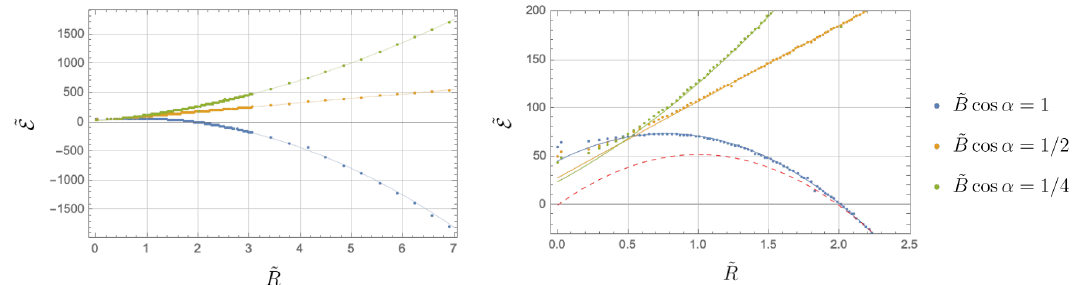
Figure 6 . The dimensionless total energy ˜ E is plotted as the function of the dimensionless radius ˜ R for d = 3 . We set ˜ B cos α = { 1 , 1 / 2 , 1 / 4 } . The right panel is the zoom-up near ˜ R = 0 of the left